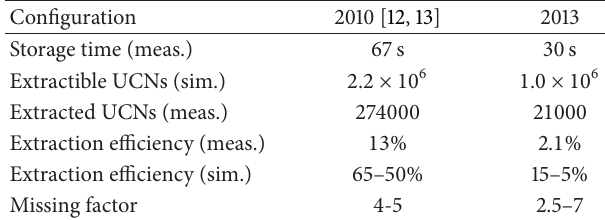
Table 3: Comparison of previous and recent measurements with simulations. The number of extractible UCNs correponds to the number of UCNs available in the source after the UCN density has been saturated according to the simulation. The number of extracted UCNs corresponds to the number of UCNs detected during the experiments. The measured (resp., simulated) extraction efficiency is the ratio of the number of UCNs detected during the measurement (resp., the simulation) to the simulated number of extractible UCNs. The missing factor is calculated according to the discrepancy between these two